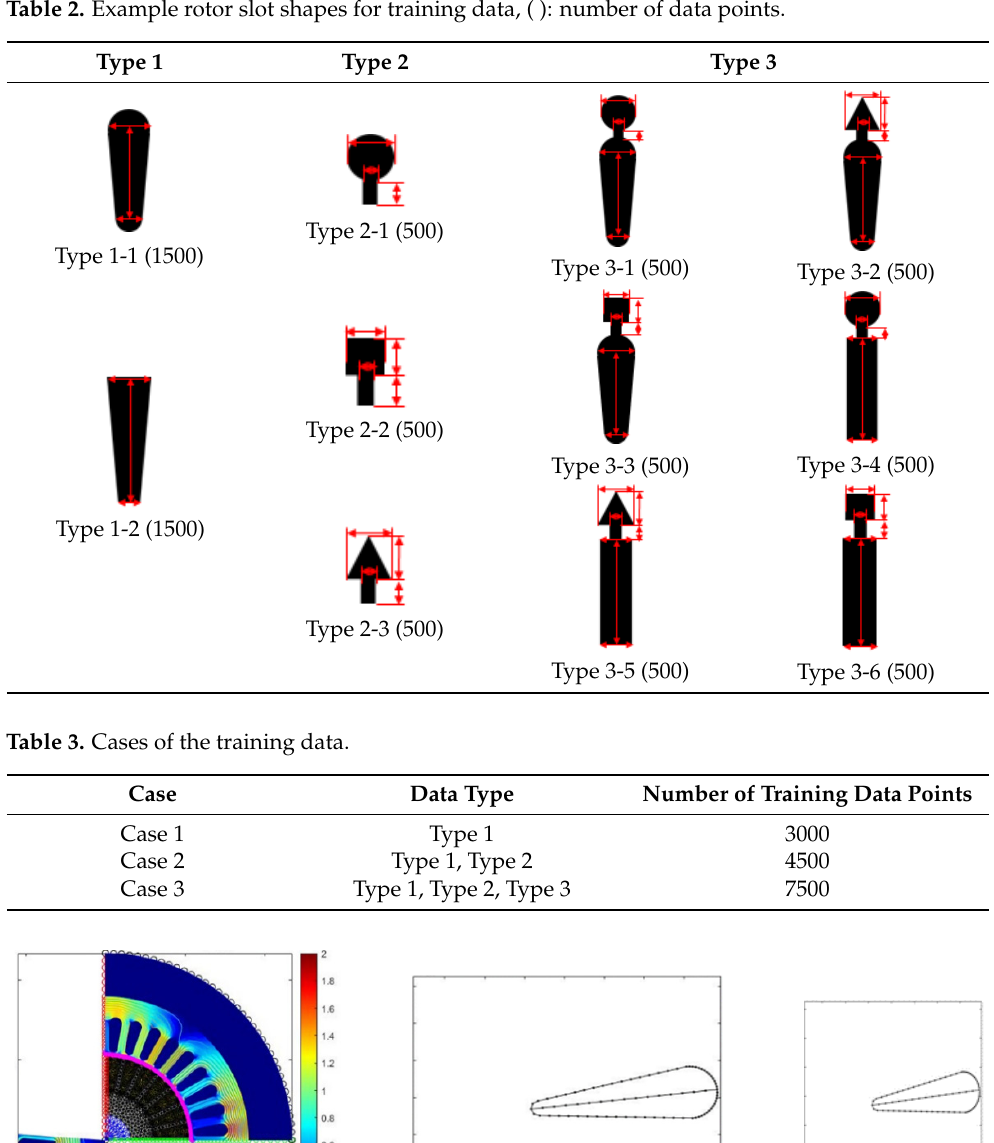
Table 2. Example rotor slot shapes for training data, ( ): number of data points.